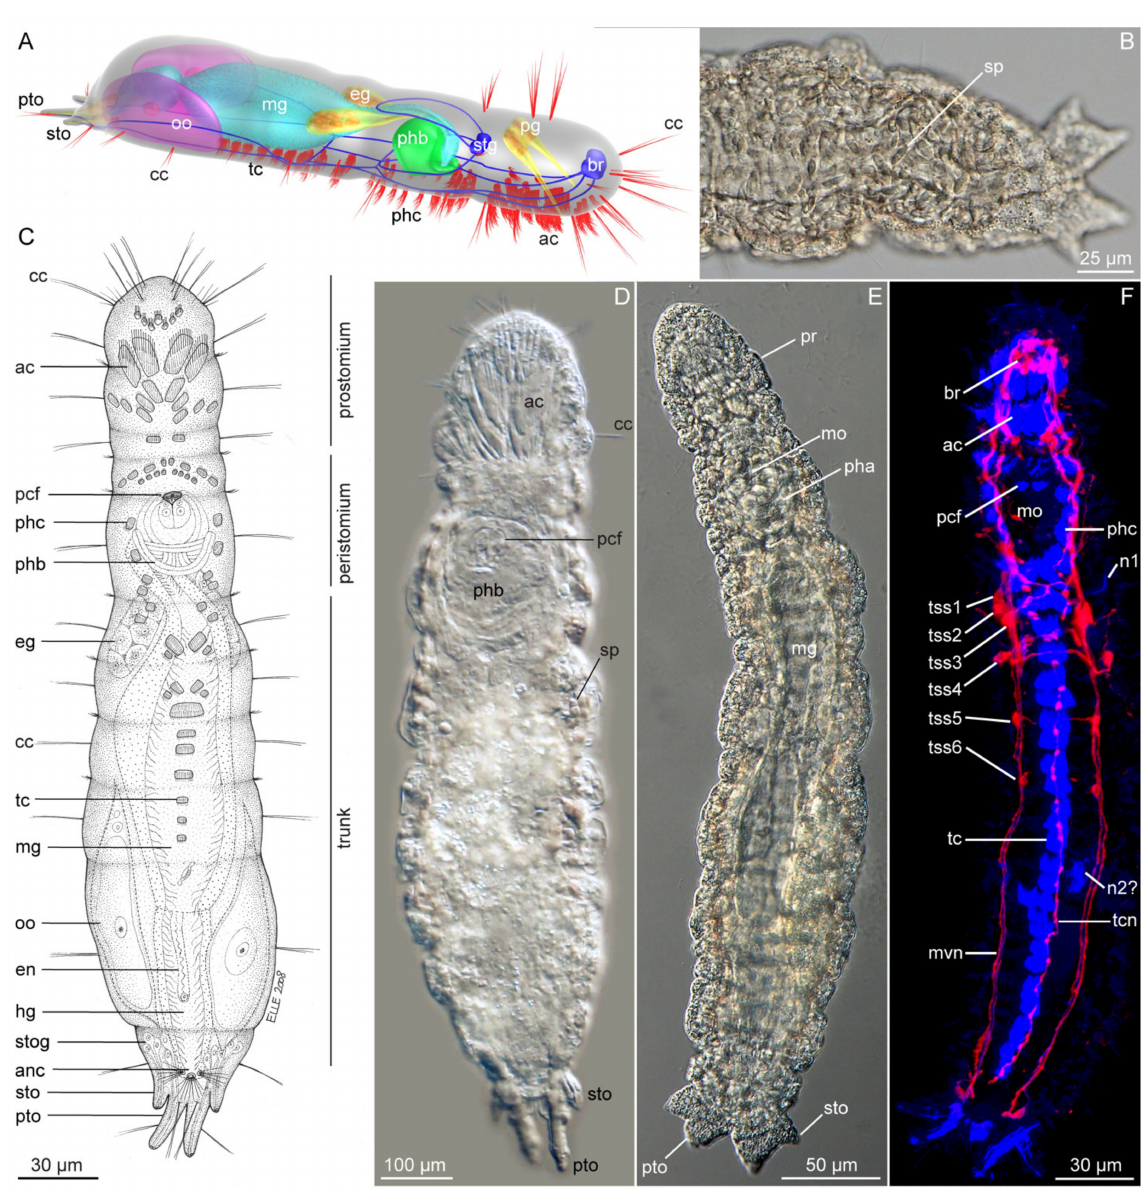
Figure 5. ( A ) Schematic illustration of Diurodrilus sp. from South Australia, Australia; ( B ) light micrograph of posterior trunk of D. subterraneus male with sperm. ( C ) Drawing of Diurodrilus sp. from Queensland, Australia, ventral side. ( D ) Light micrograph of male Diurodrilus sp. from Aomori, Japan. ( E ) Light micrograph of female D. subterraneus . ( F ). Confocal laser scanning microscopy (CLSM), maximum intensity projection of Z-stack images of D. subterraneus showing anti-acetylated α -tubulin like immunoreactivity (LIR) (blue) and anti-serotonin LIR (red). ( C , E , F )—modified from [25]. Abbreviations: ac, anterior head ciliophore; anc, anal ciliary field; br, brain; cc, compound cilia; eg, esophageal gland; en, enteronephridium; hg, hindgut; mg, midgut; mo, mouth opening; mvn, main ventral nerve; n1–2, nephridium 1 and 2; pcf, prepharyngeal ciliary field; pg, prostomial gland; pha, pharynx; phb, pharyngeal muscle bulb (bowl-shaped); phc, peripharyngeal ciliophore; pr, prostomium; pto, primary toe; oo, oocyte; oon, oocyte nucleus; sp, spermatozoa; sto, secondary toe; stog, secondary toe gland; stg, stomatogastric ganglion; tc, trunk ciliophore; tcn, trunk ciliophore nerve; tss1–6, first to sixth pairs of trunk anti-serotonin LIR